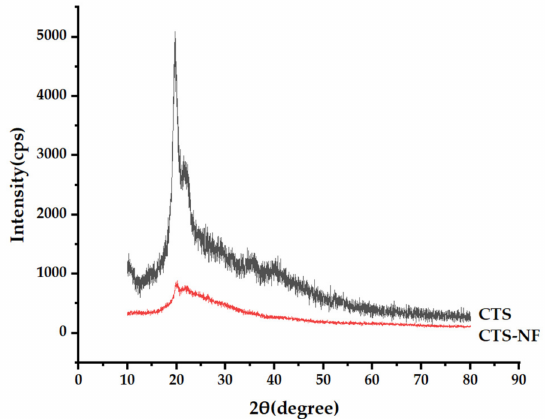
Figure 4. XRD patterns of CTS-NF and CTS.